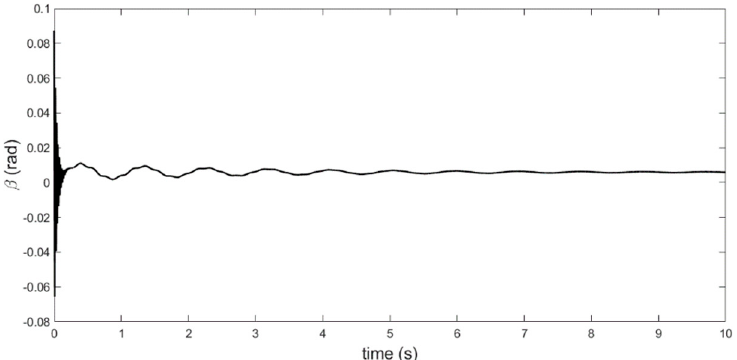
Figure 6. Time response of beta in lower speed of flutter (20 m/s).